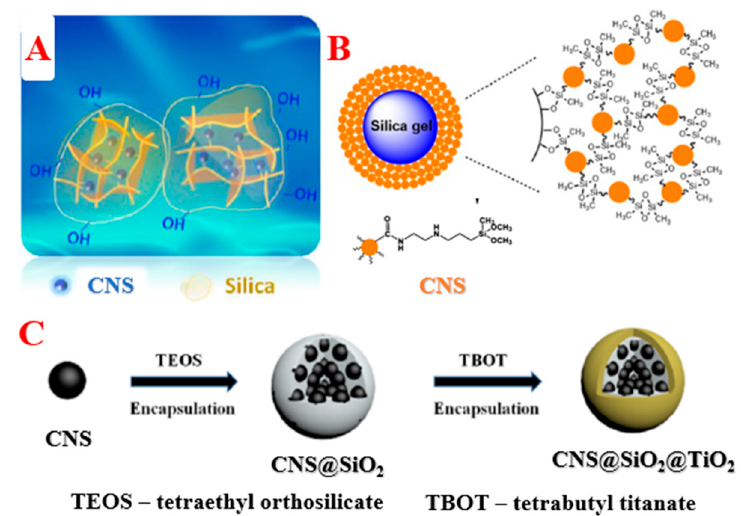
Figure 1. Schematic illustration of the composite formation: inclusion of CNSs into the silica matrix ( A ) [38], grafting of CNSs onto the silica surface ( B ) [22], and synthesis of bifunctional complexes ( C ) [39]. Adapted with permission from [38], ACS 2019, [22], Springer 2017, and [39], Elsevier